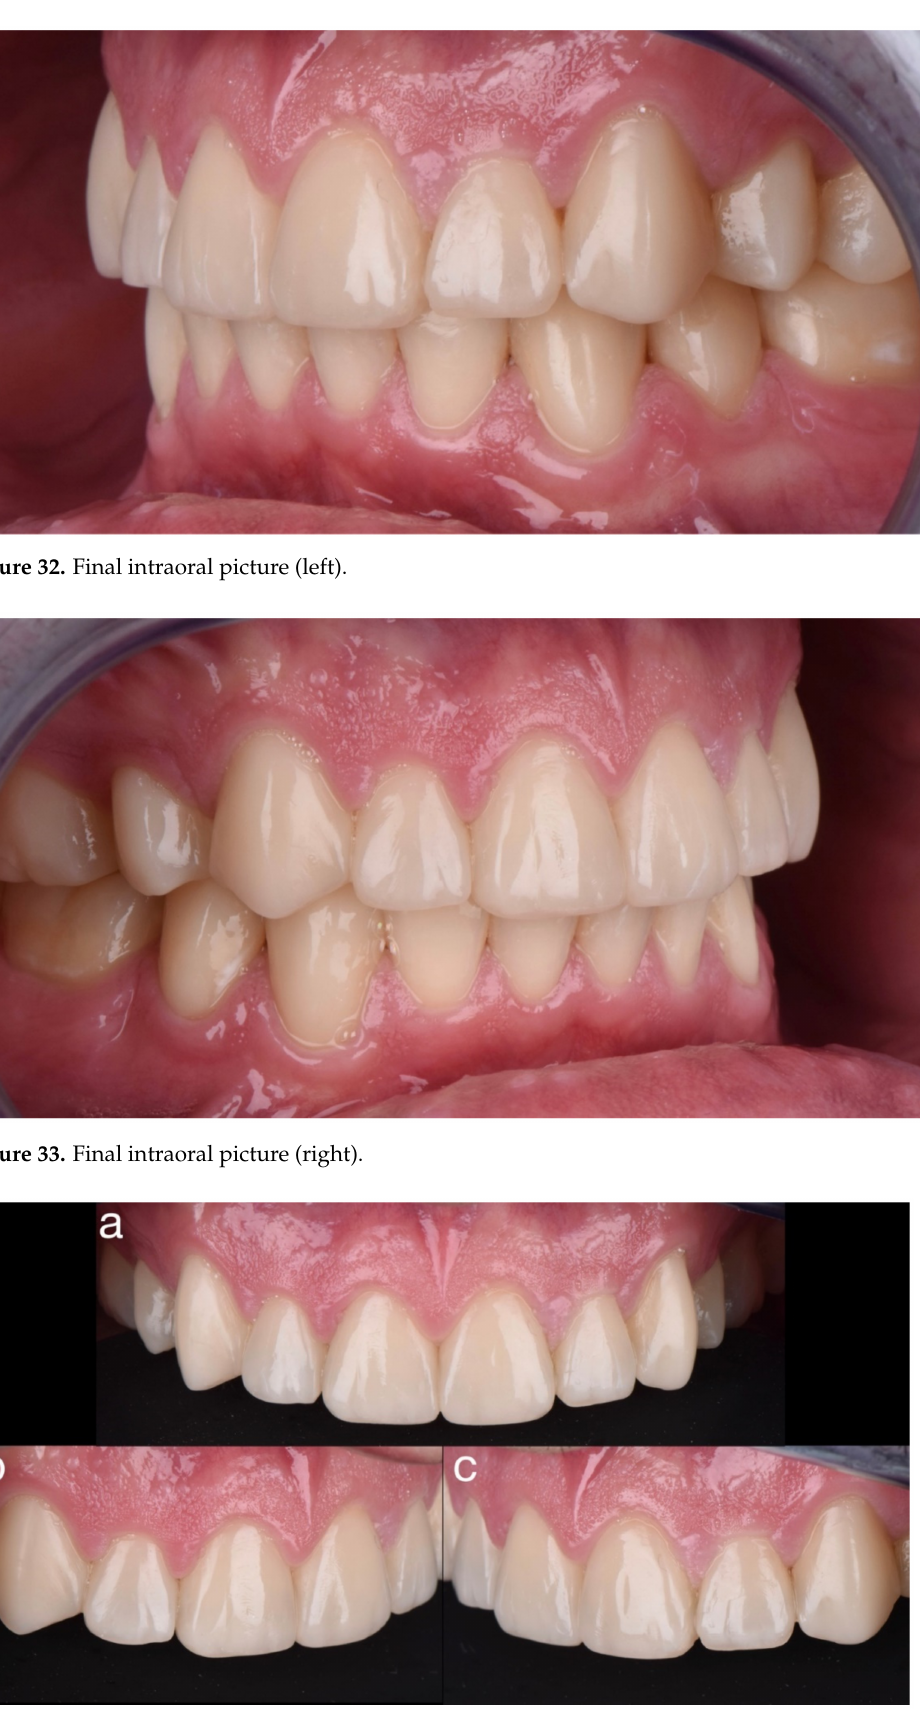
Figure 34. Final upper anterior restorations (( a ) frontal, ( b ) right, ( c )